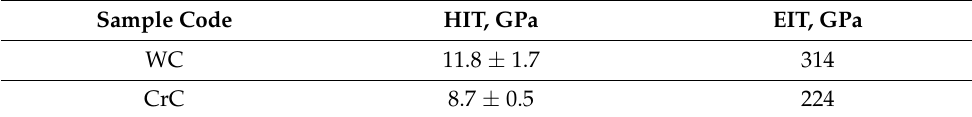
Table 6. The mechanical properties of the coatings in the as-sprayed condition.